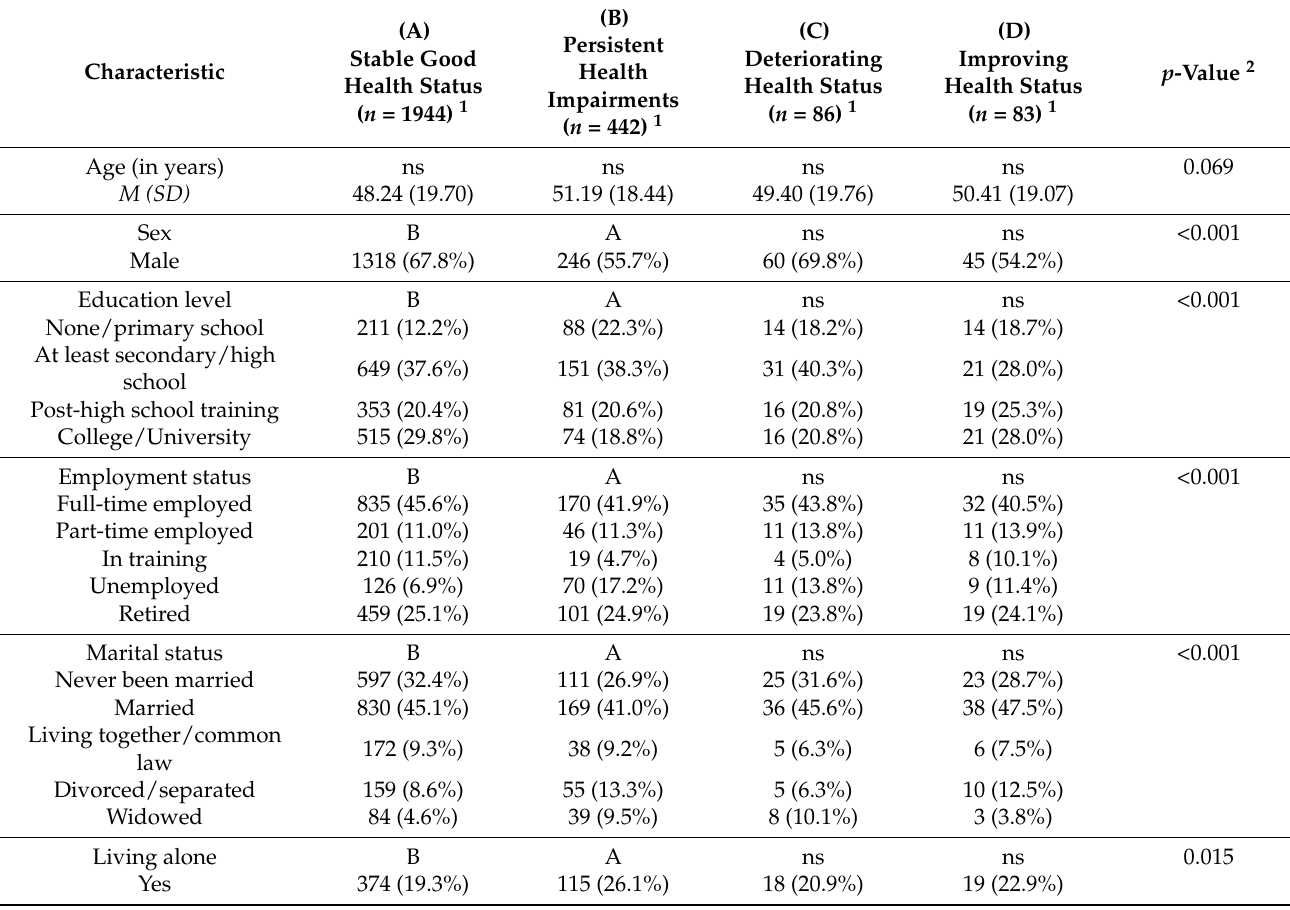
Table A11. Descriptive sociodemographic statistics for the four classes of TBI-specific and generic HRQoL trajectories.